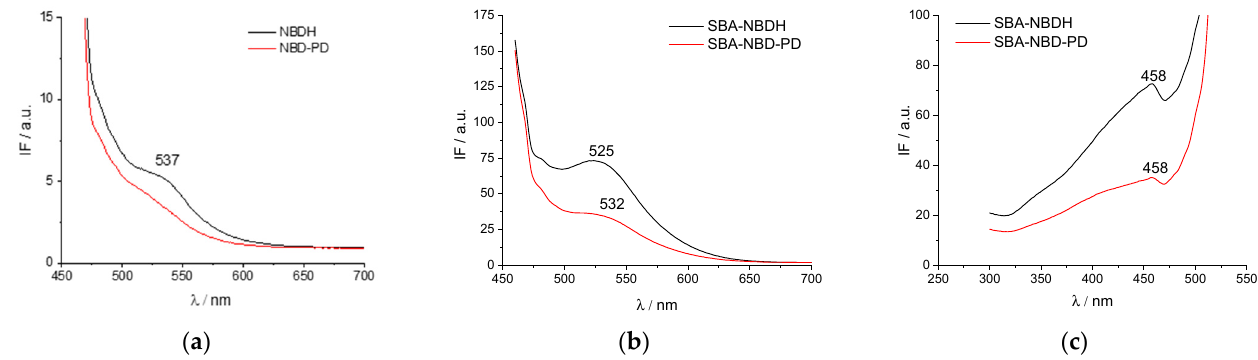
Figure 9. Fluorescence emission spectra of NBDH and NBD-PD ( a ), of SBA-NBDH and SBA-NBD- PD ( b ), λ ex = 450 nm, and fluorescence excitation spectra of SBA-NBDH and SBA-NBD-PD ( c ), λ em = 530 nm.